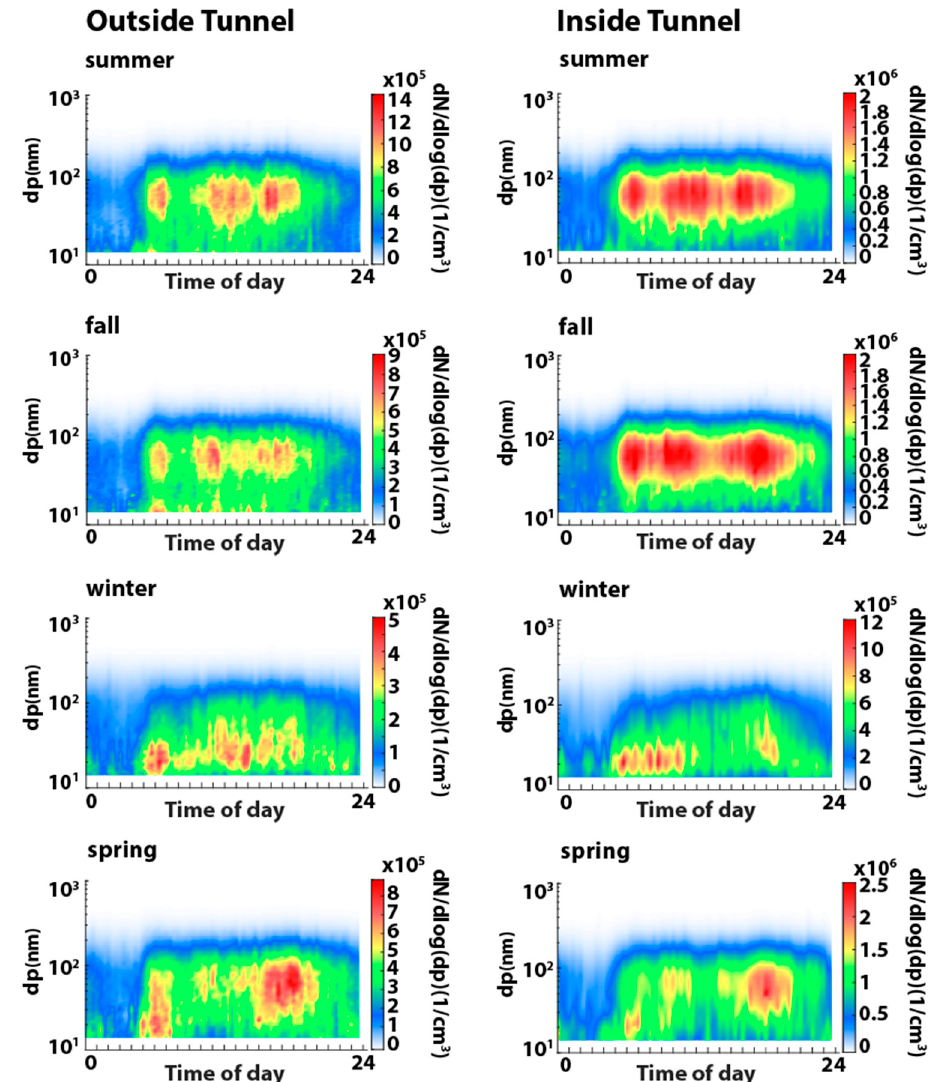
Figure 6. Diurnal patterns of seasonal particle size distribution in the inside- and outside of the tunnel estimated by using SMPS.